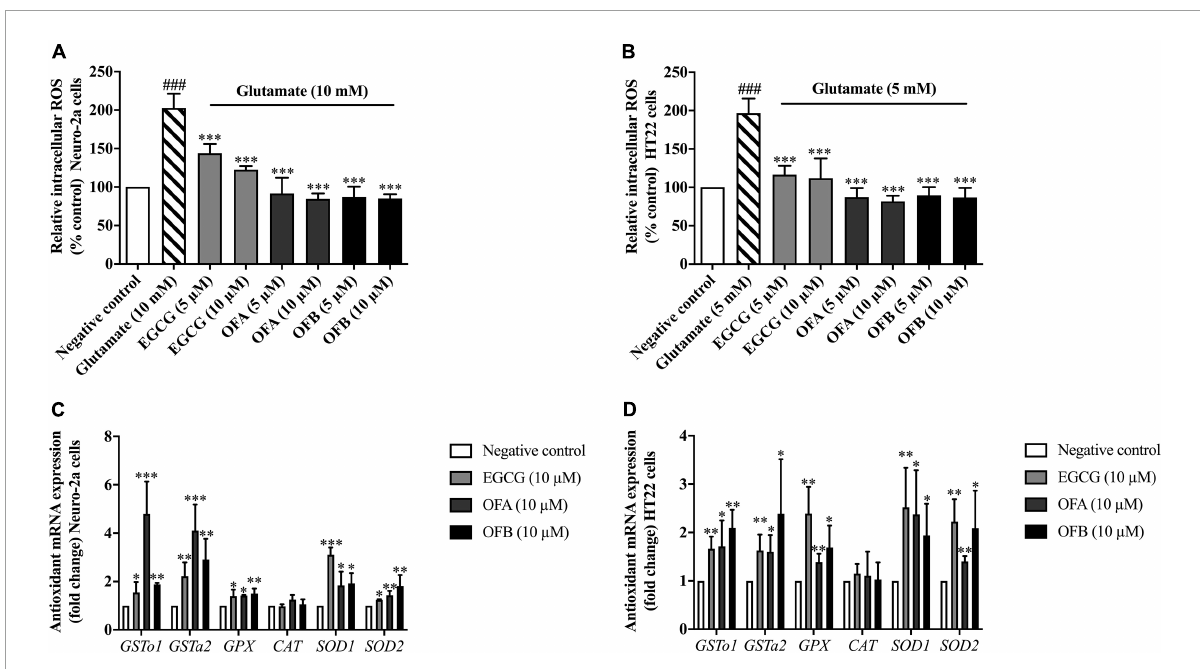
FIGURE4 Protective effect of EGCG, OFA, and OFB in Neuro-2a and HT22 cells against glutamate-induced oxidative stress by suppressing intracellular ROS and enhancing the antioxidant gene expression. After treated with EGCG, OFA, and OFB in Neuro-2a (A) and HT22 cells (B) , the intracellular ROS were measured. Samples were exposed to glutamate (5–10 mM) to induce oxidative stress. The endogenous antioxidant gene expression in Neuro-2a (C) and HT22 cells (D) . β -Actin was used in RT-PCR assay as internal control. Results are shown as the mean ± standard deviation ( n ≥ 3 independent experiments). ### p < 0.001 compared to the negative control; ∗ p < 0.05, ∗∗ p < 0.01, and ∗∗∗ p < 0.001 compared to the glutamate treated